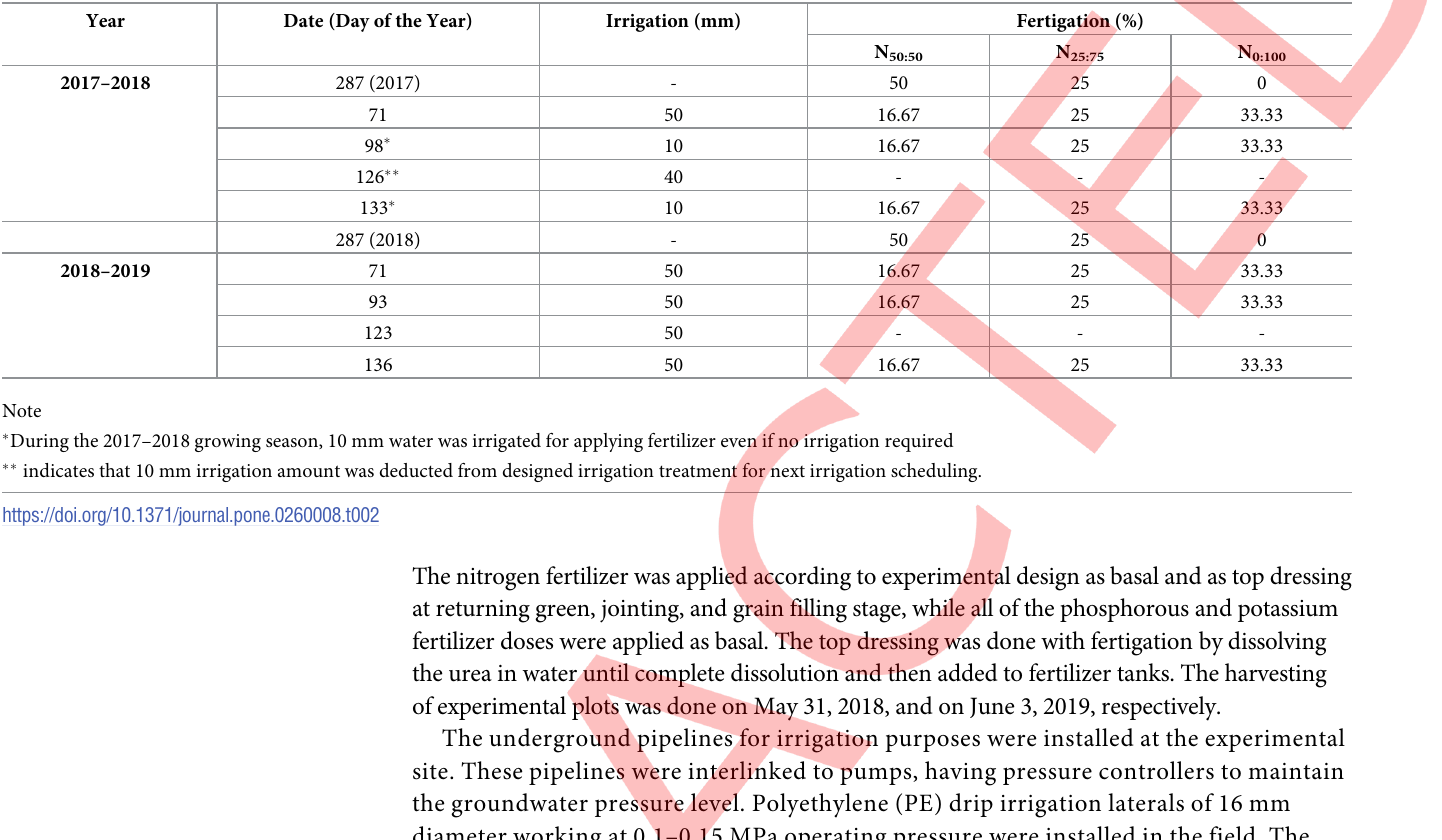
Table 2. Irrigation scheduling and fertigation for all treatments during the 2017–2018 and 2018–2019 wheat